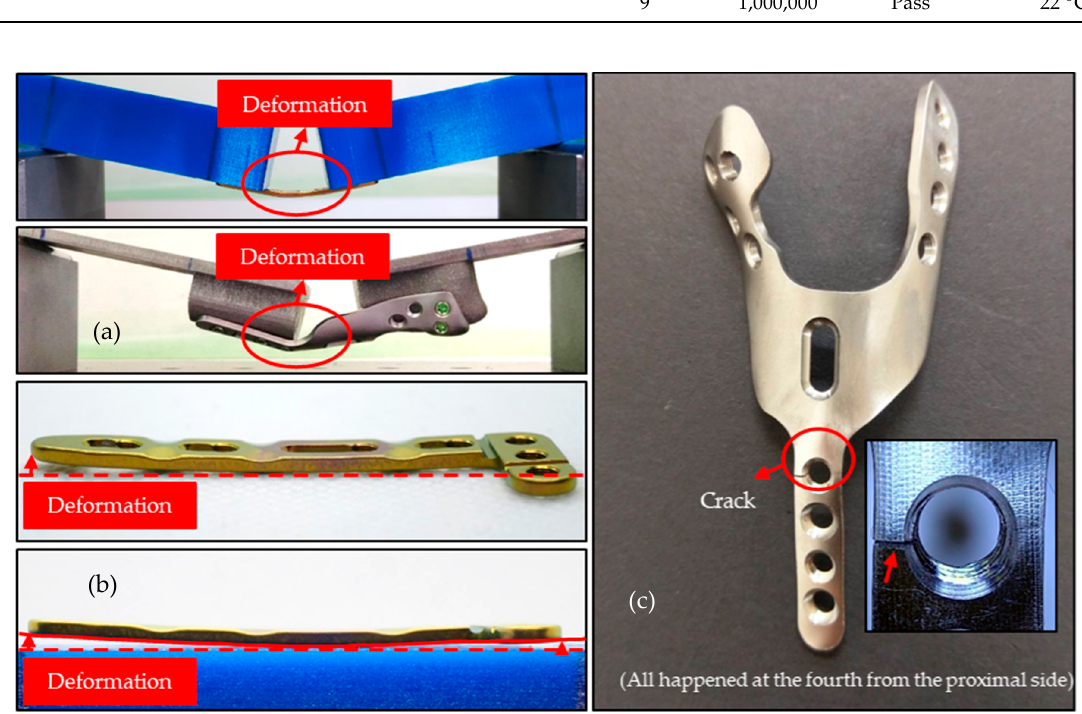
Figure 6. HDDP and DDP group case failure patterns. Deformations of ( a ) HDDP; ( b ) DDP and ( c ) cracks of HDDP. The biomechanical fatigue test result showed that average axial displacement values under axial load for the HDDP and DDP groups were 0.4218 mm and 0.5162 mm, respec- tively. Corresponding HDDP and DDP group values for lateral displacement under bending were 1.7623 mm and 2.2045 mm; rotational degrees under torsion were 1.9625 ◦ and 1.9736 ◦ , respectively (Figure 7). All variations of obtained values under axial load, bending, and torsion showed no significant differences between the HDDP and DDP groups (Table